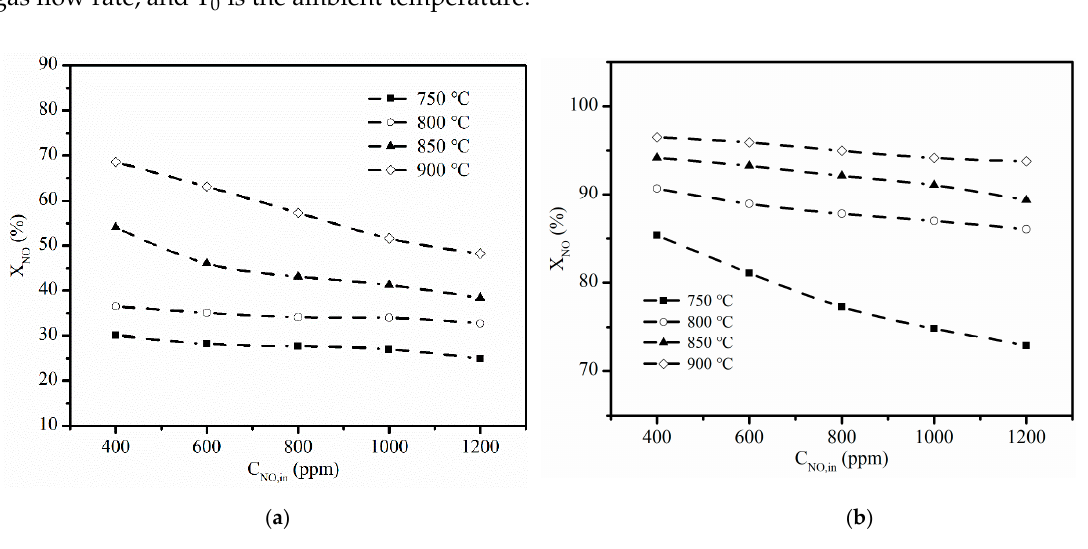
Figure 7. NO reduction rate of rice husk char at different inlet NO concentrations, for the ( a ) char–NO system and ( b ) char–NO–CO system.